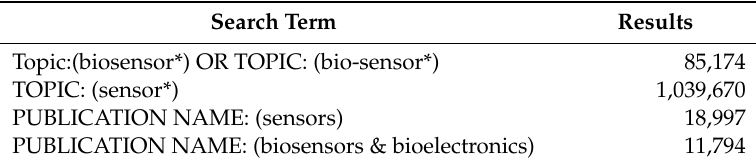
Table 1. Overview of searches conducted in WoS on 8 May